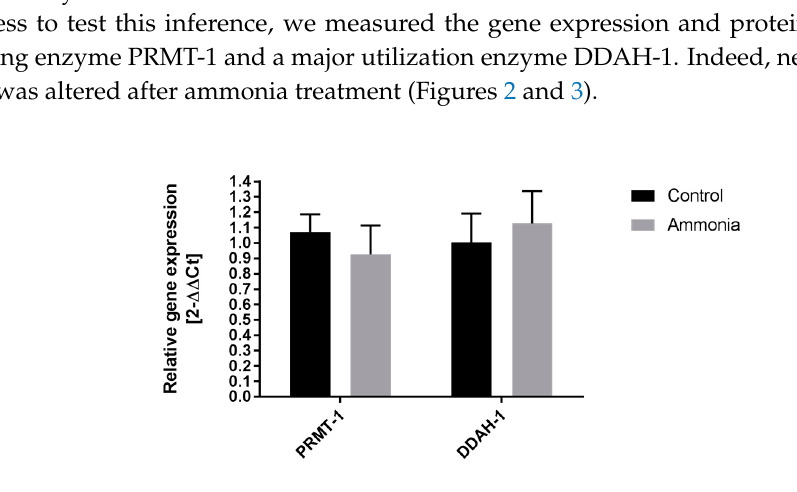
Figure 2. Expression of mRNAs coding for enzymes of ADMA metabolism, PRMT1 and DDAH1 genes in control and ammonia-treated astrocytes.